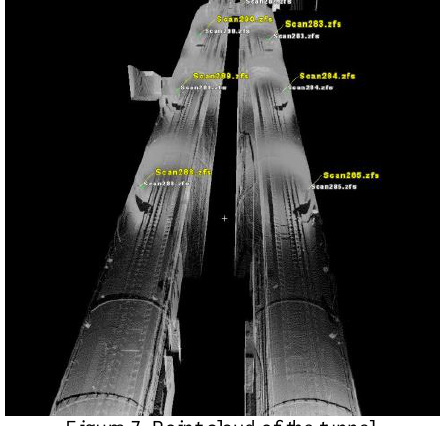
Figure 7. Point cloud of the tunnel